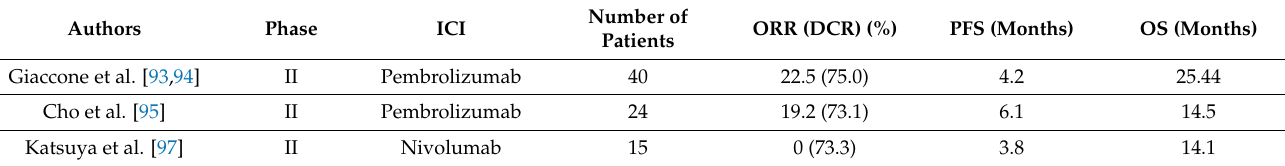
Table 2. The efficacy of immunotherapy for thymic carcinoma in clinical